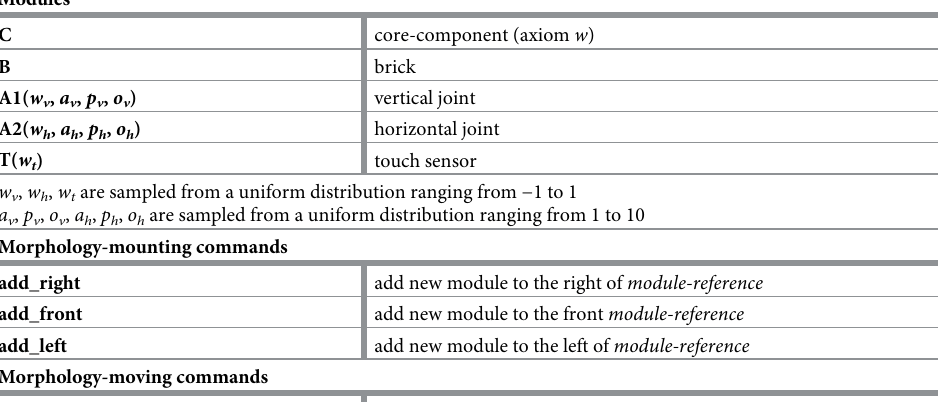
Table 1. Alphabet of the grammars. Terminology is explained in Section 3.5.2.